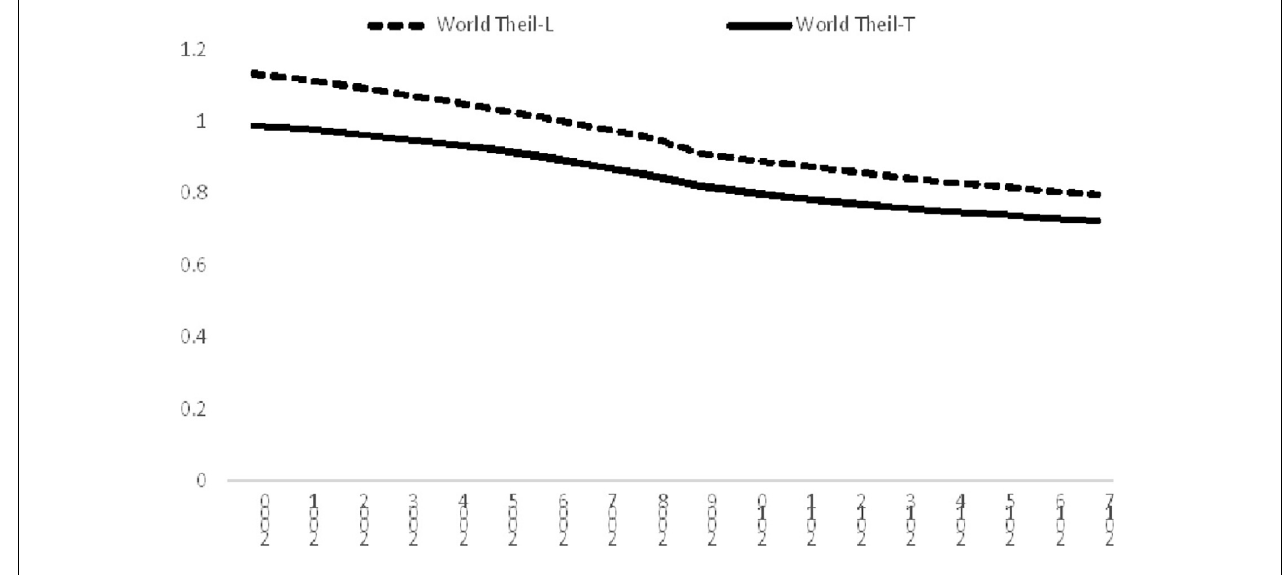
FIGURE 1 | Income inequality in the World, 2000–2017. Source: Authors’ calculation.